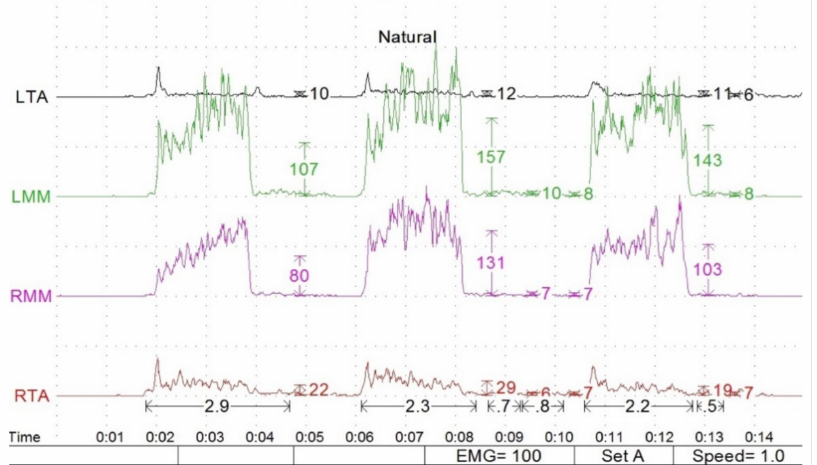
Figure 11. EMG/K7 analysis at rest (age 23). The following muscles were recorded: left temporalis anterior (LTA), left masseter (LMM), right masseter (RMM), right temporalis anterior